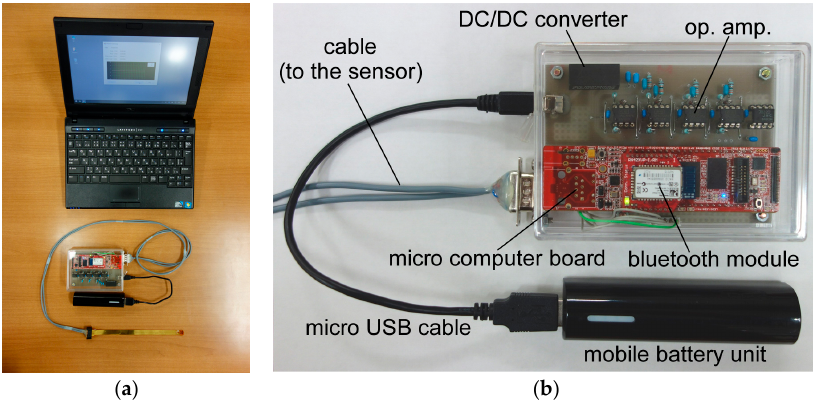
Figure 6. Measurement system for the shear force sensor: ( a ) Whole system; and ( b ) Expanded photograph of the measurement circuit.